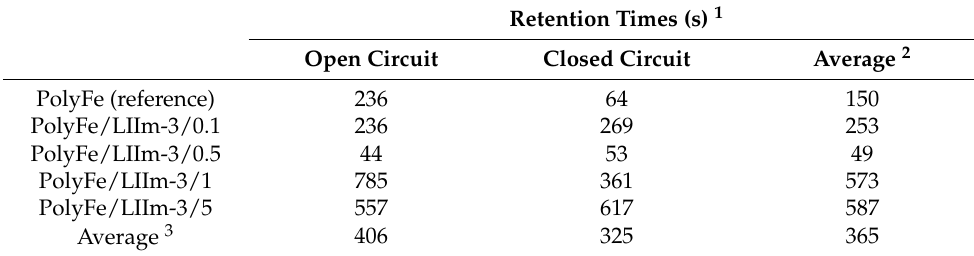
Table 1. Retention times of the colorless state for polyFe/LIIm composite